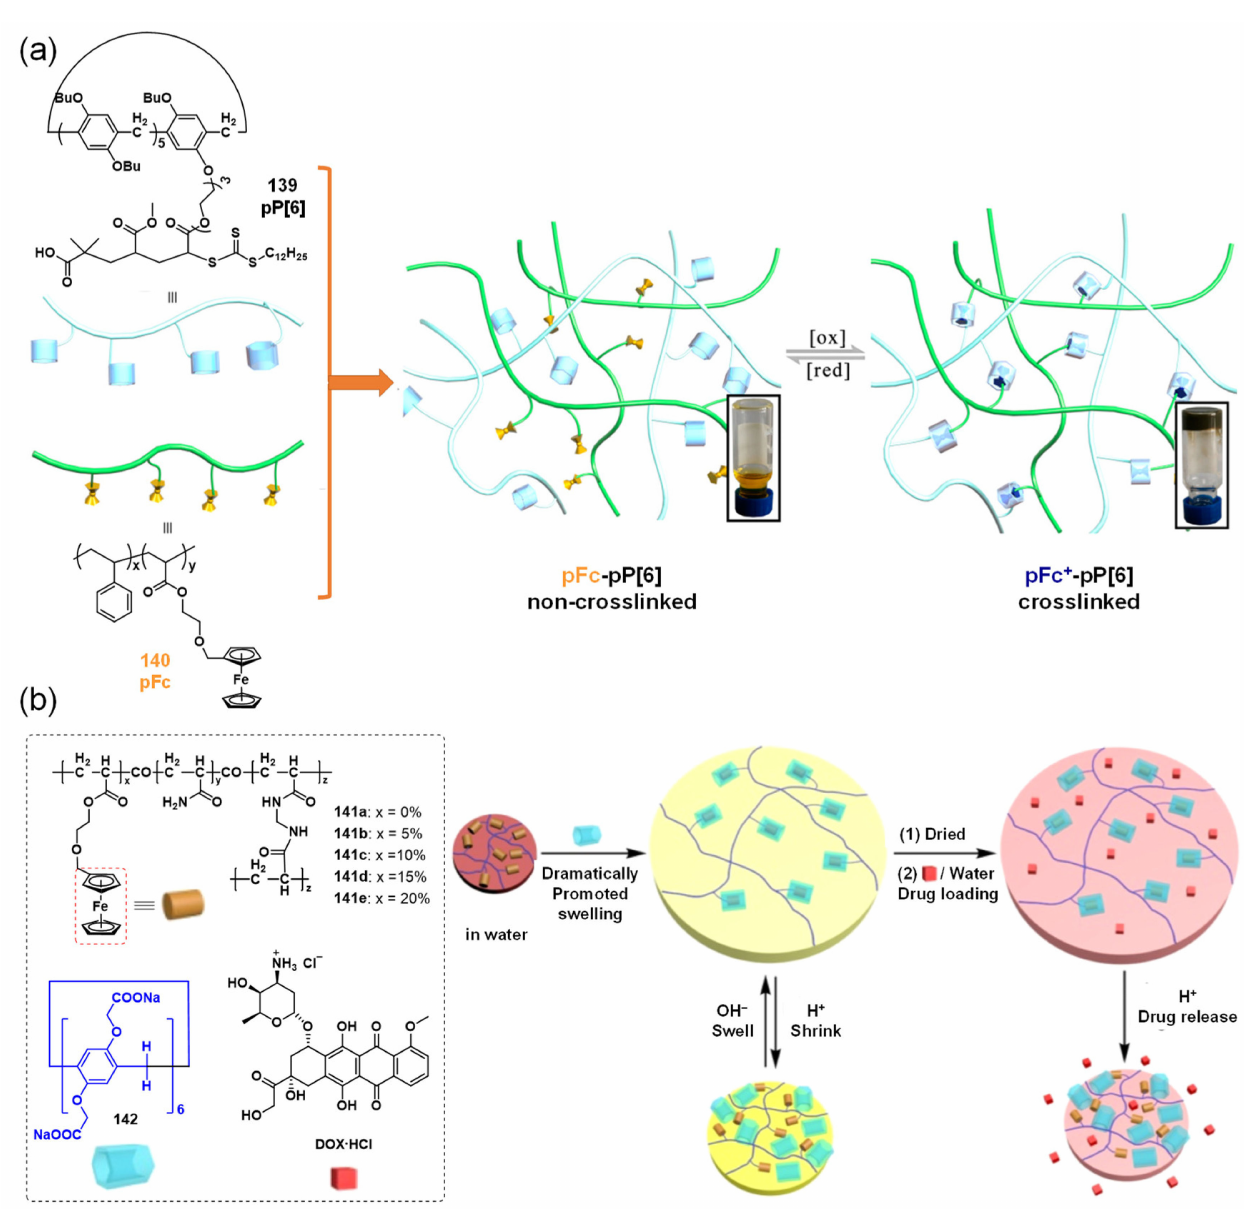
Figure 55. ( a ) Representation of the redox-controllable supramolecular network pFc+-pP [6] based on the functionalized polymers 139 and 140 . ( b ) Illustration of the dramatically promoted swelling of gels via 142 − ferrocene host − guest interactions and subsequent pH-responsive swelling − shrinking transition, and their application in controlled drug (DOX · HCl) release. Reprinted with permission from Refs. [137,138]. Copyright (2015, 2016), American Chemical